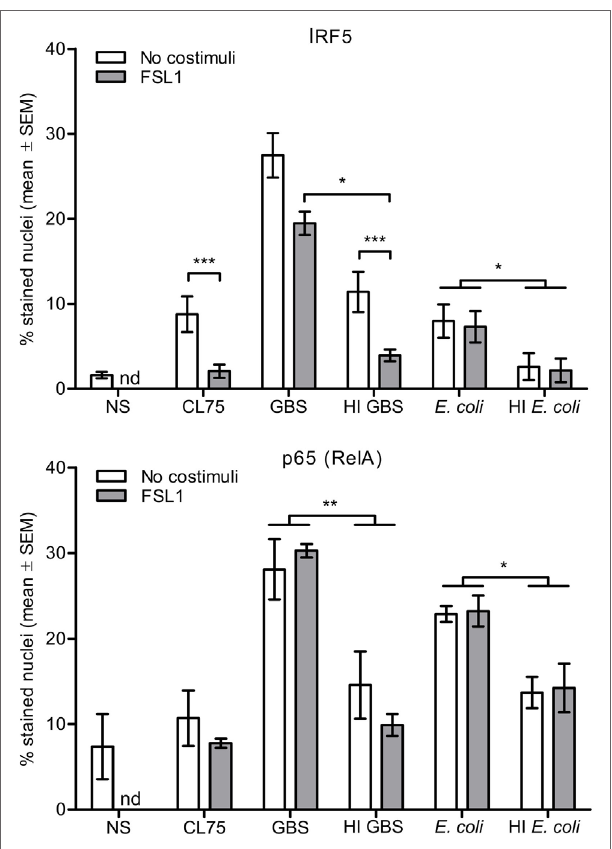
FigUre 5 | Activation of IFN regulatory factor 5 (IRF5) by TLR8 ligand and Group B Streptococcus (GBS) is antagonized by TLR2 costimulation, while activation of IRF5 by viable Escherichia coli is not. Monocytes were stimulated with CL75 (1 μ g/ml), viable or heat-inactivated (HI) GBS (MOI 1.0) and E. coli (MOI 2.0), and with or without FSL-1 costimulation (100 ng/ml) for 2 h. The monocytes were subsequently fixed and double IF stained IRF5 and p65/RelA. Nuclear accumulation was quantified by high-content screening (Scan^R, 20 × ). NS, no stimuli. nd, not done. n = 4.